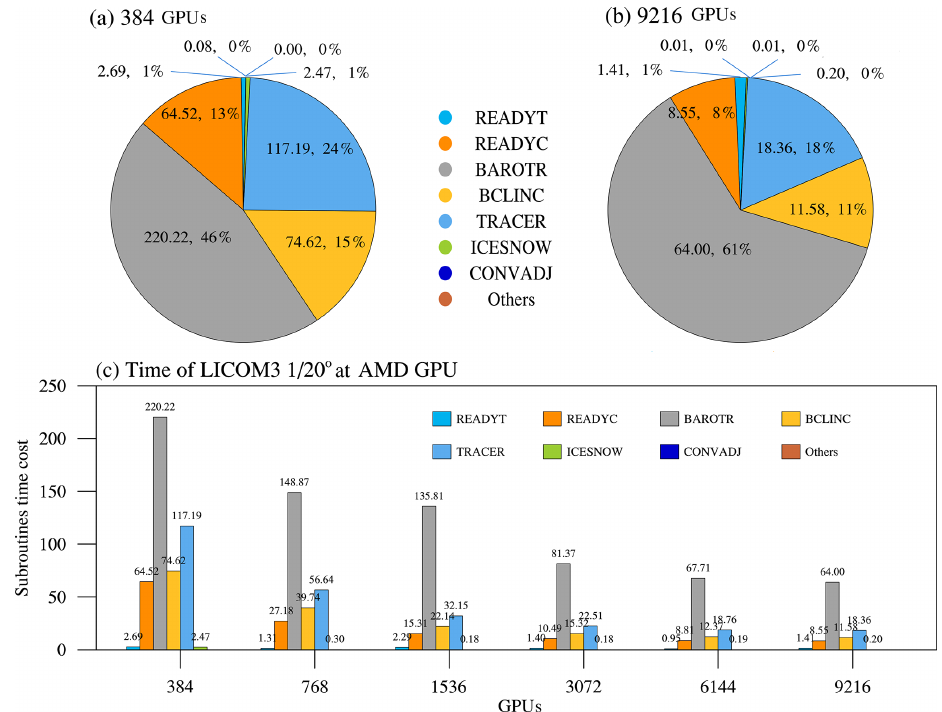
Figure 12. The seven core subroutines’ time cost percentages for (a) 384GPUs and (b) 9216GPUs. (c) The subroutines’ time cost at different scales of LICOM3-HIP (1 / 20 ◦